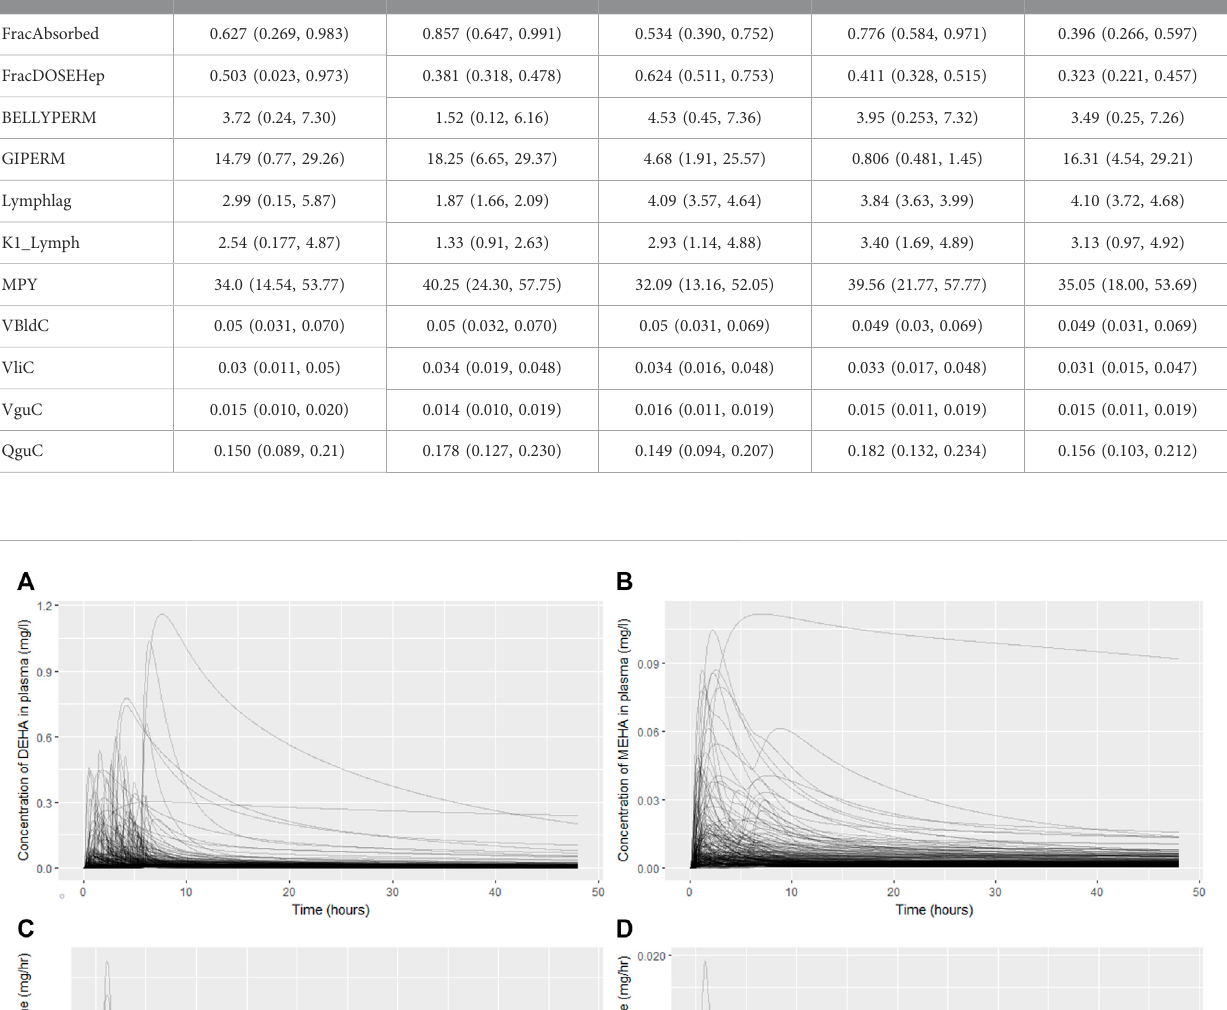
TABLE 5 Local posterior distributions.